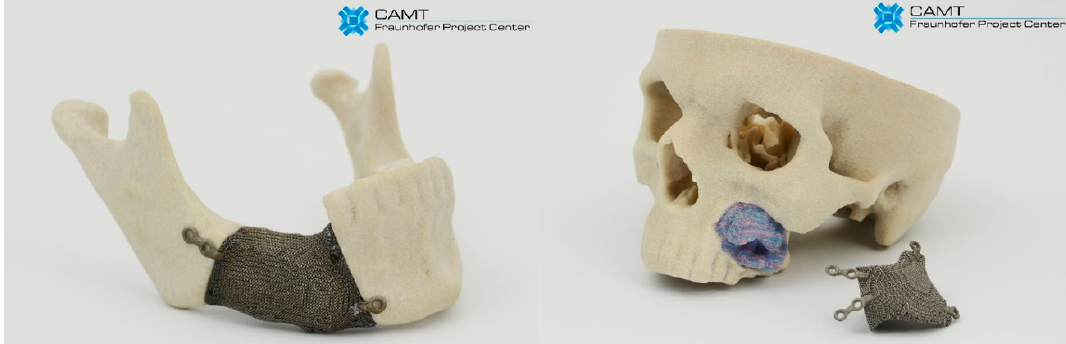
Figure 14. Examples of custom-made implants made of Ti6Al7Nb alloy filled with BFS.